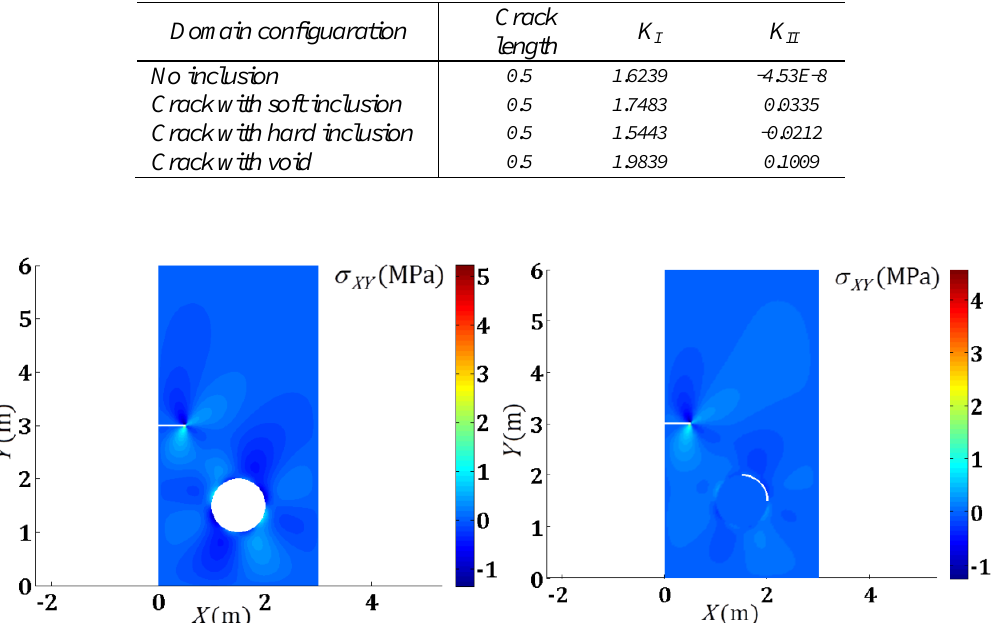
Figure 15. Crack-inclusion interaction problem: void-crack (left figure), and crack-inclusion (right